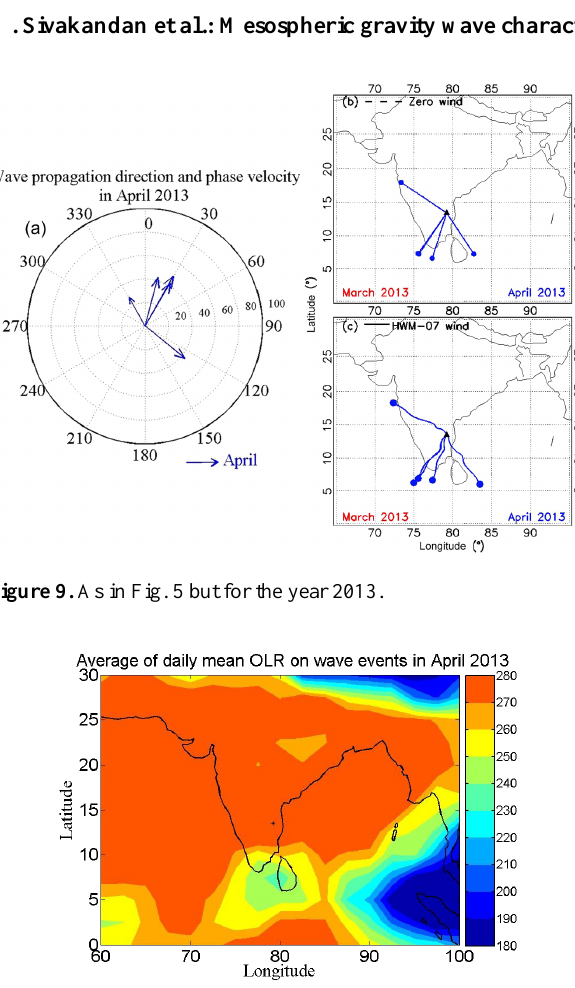
Figure 10. As in Fig. 7 but for the year 2013.